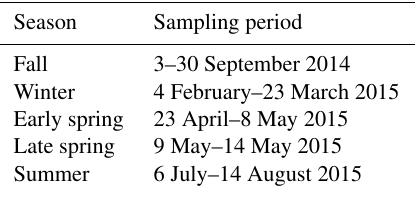
Table 1. Seasonal sampling periods in Baltimore,